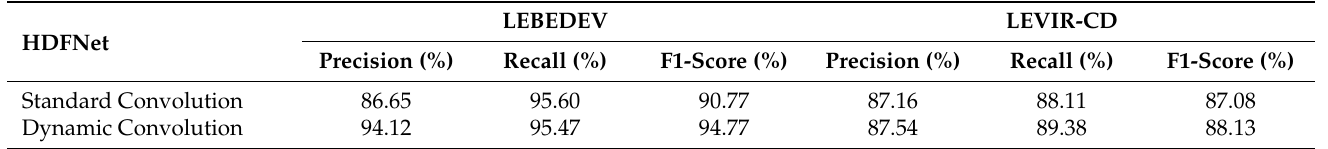
Table 5. Ablation study of with/without dynamic convolutional layers (presented as